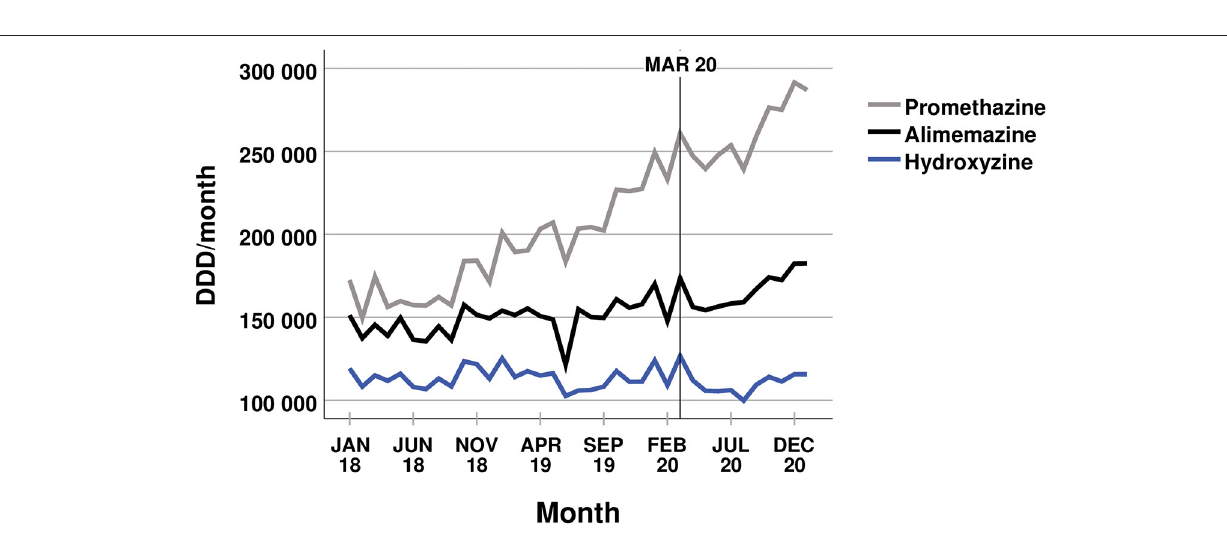
FIGURE 3 | Dispensed amounts of promethazine, alimemazine, and